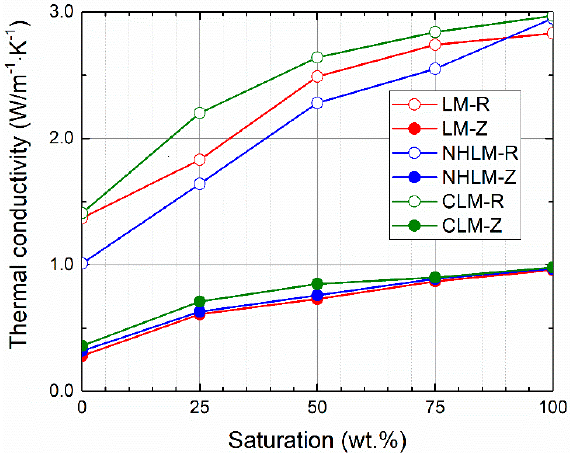
Figure 6. Moisture-dependent thermal conductivity—90-day samples.